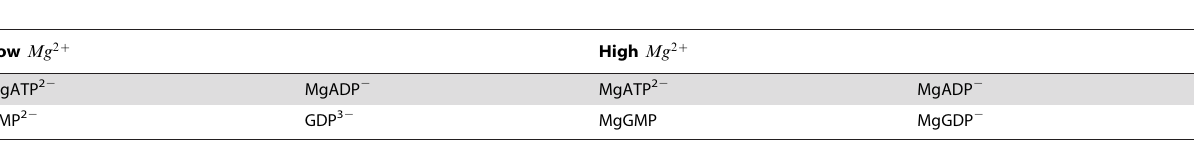
Table 3. The coordination states for the reaction substrates and products in both low and high Mg 2 + conditions.